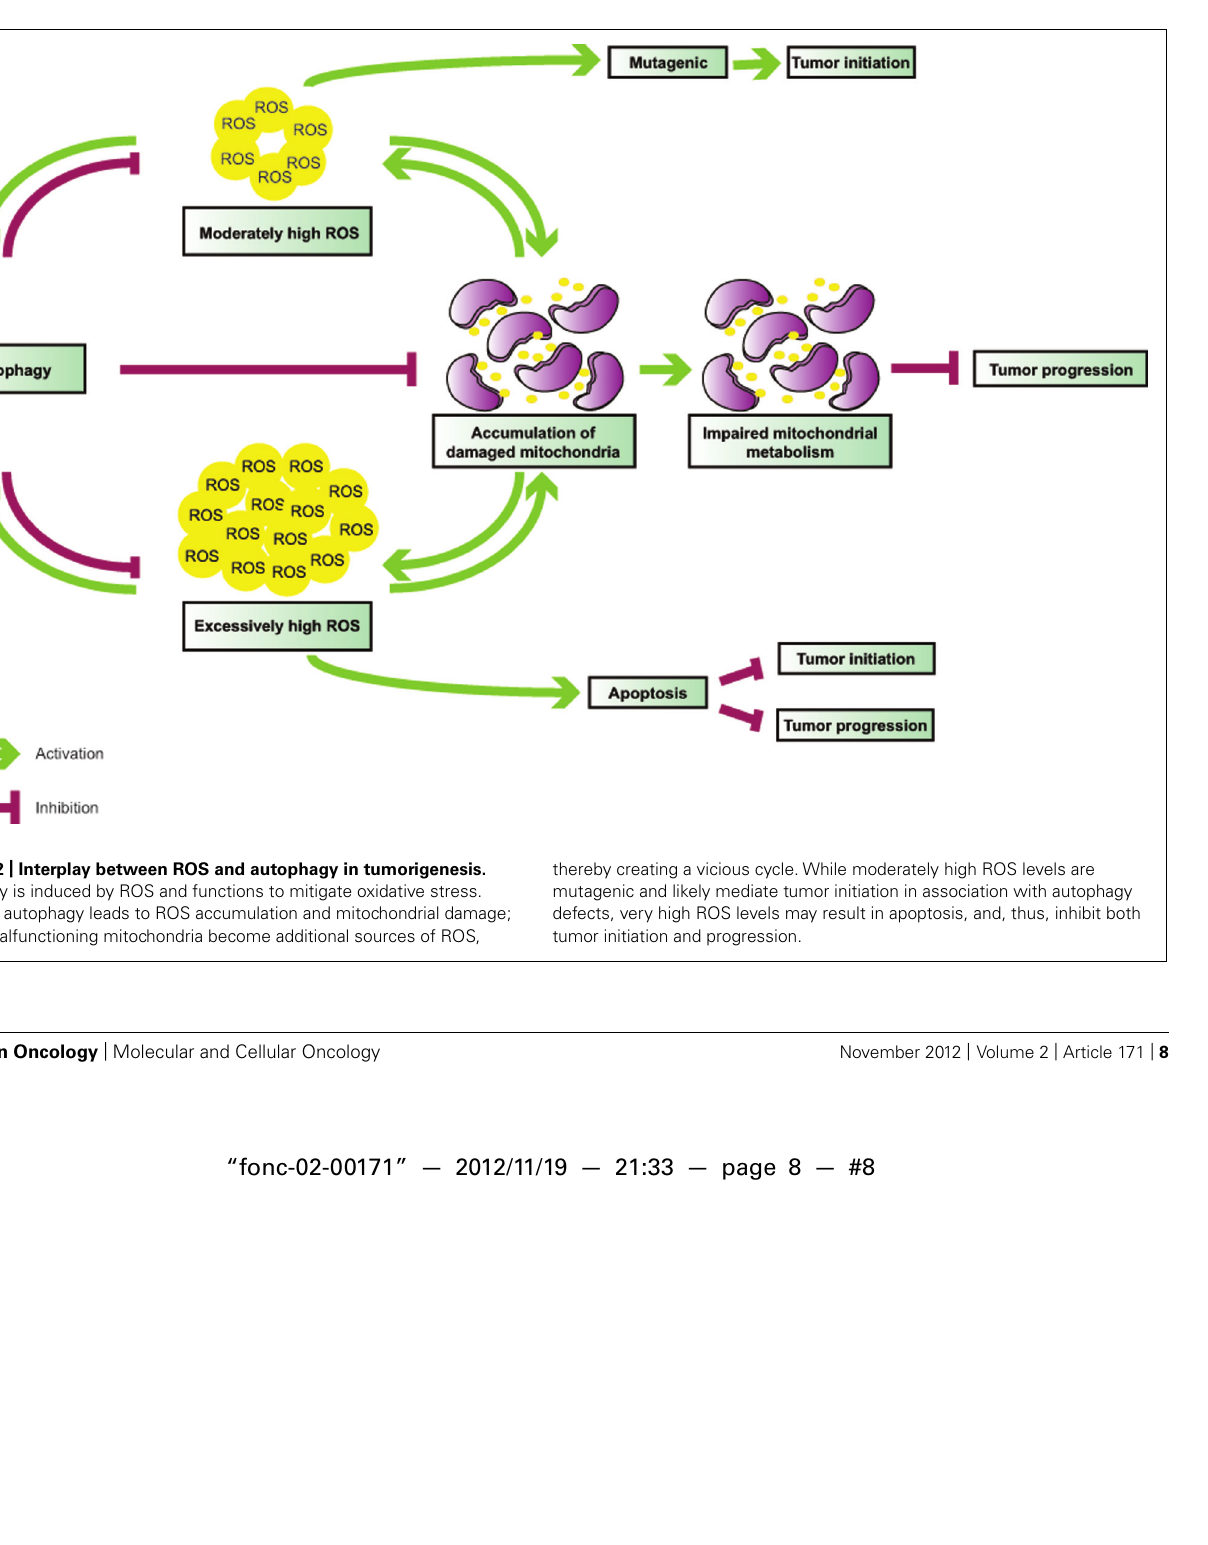
Frontiers in Oncology | Molecular and Cellular